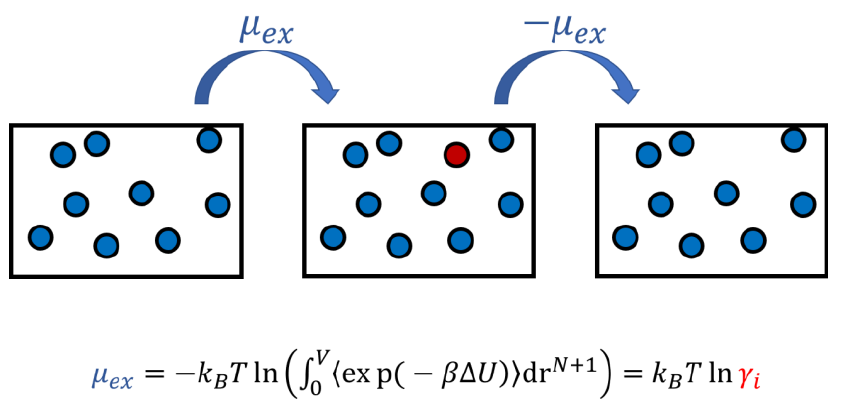
Figure 5. Illustration of Widom’s particle insertion method. The red dot represents the inserted particle and blue dots are other particles in the system.